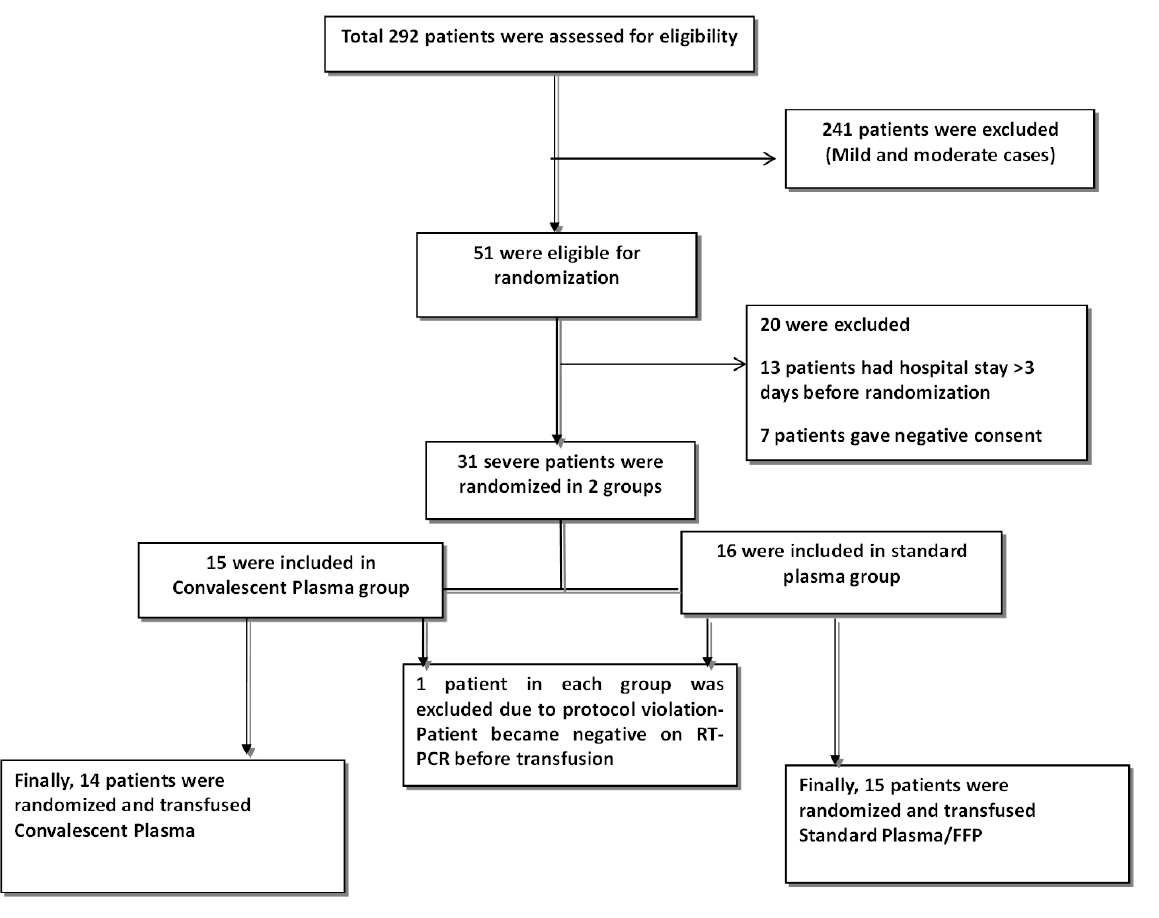
Figure 1. Patient selection and